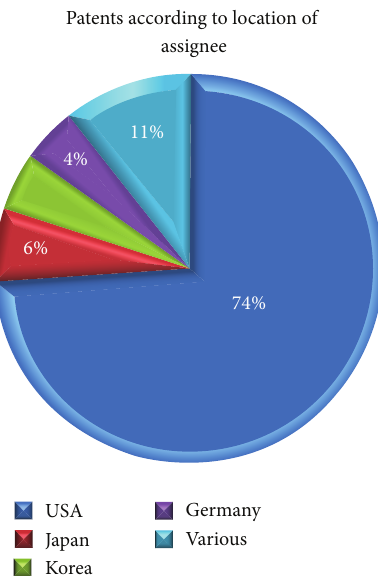
Figure 8: Overview of assignees’ locations (based on a